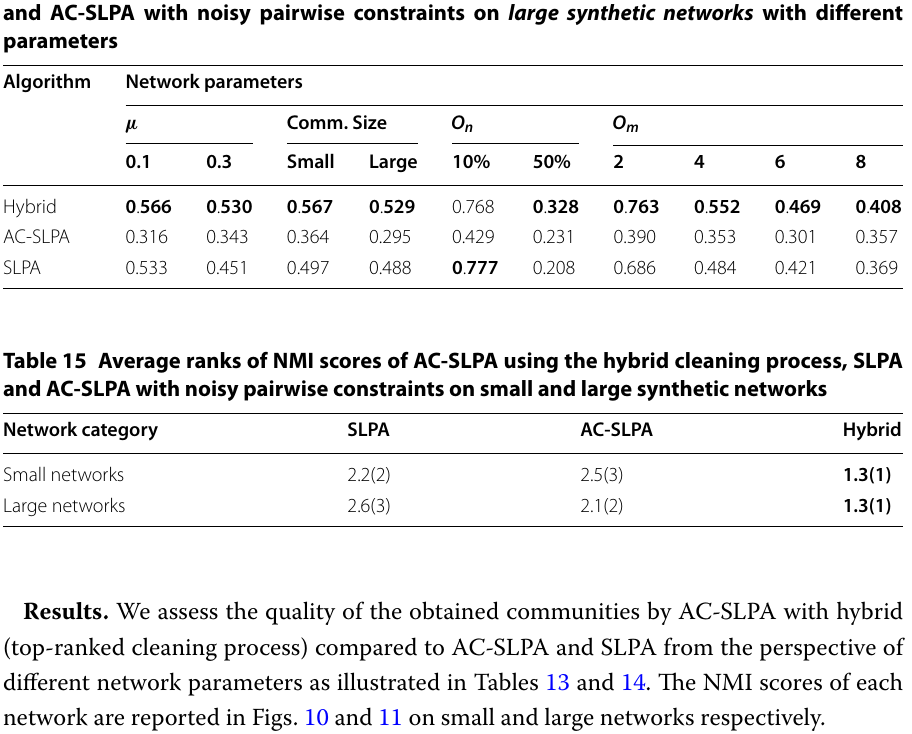
Table 14 Average NMI scores of AC-SLPA using the hybrid cleaning process, SLPA and AC-SLPA with noisy pairwise constraints on large synthetic networks with different parameters Algorithm